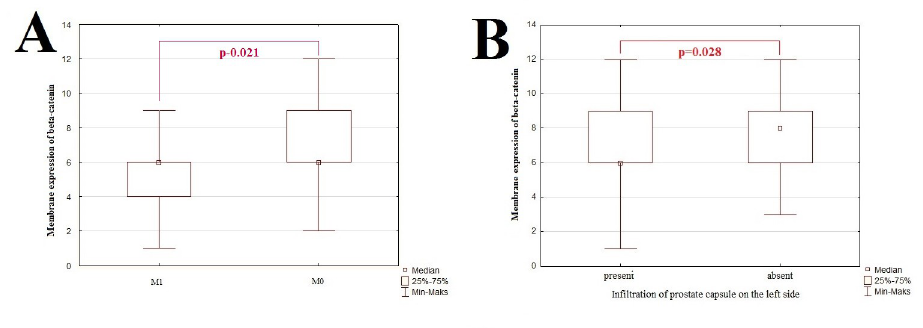
Fig 3. The graphic representation of results for membrane expression of β -catenin examined by IHC technique. The x-axis shows individual clinicopathological features and the y-axis shows IRS score values for IHC staining. The p- value < 0.05 was considered as a statistically significant. Correlation between membrane expression of β -catenin and distant metastasis (A) and infiltration of prostate capsule on the left side (B).